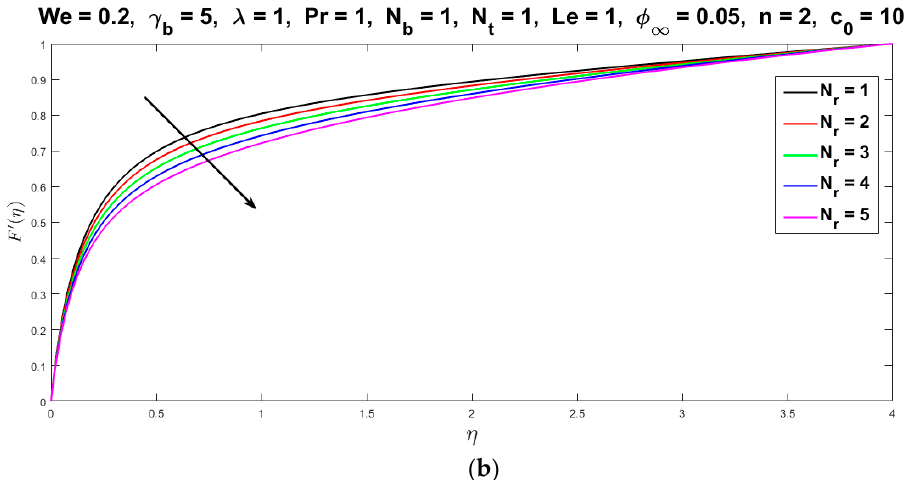
(cid:48) . ( b ) Effects of N (cid:48) . t over F b over F